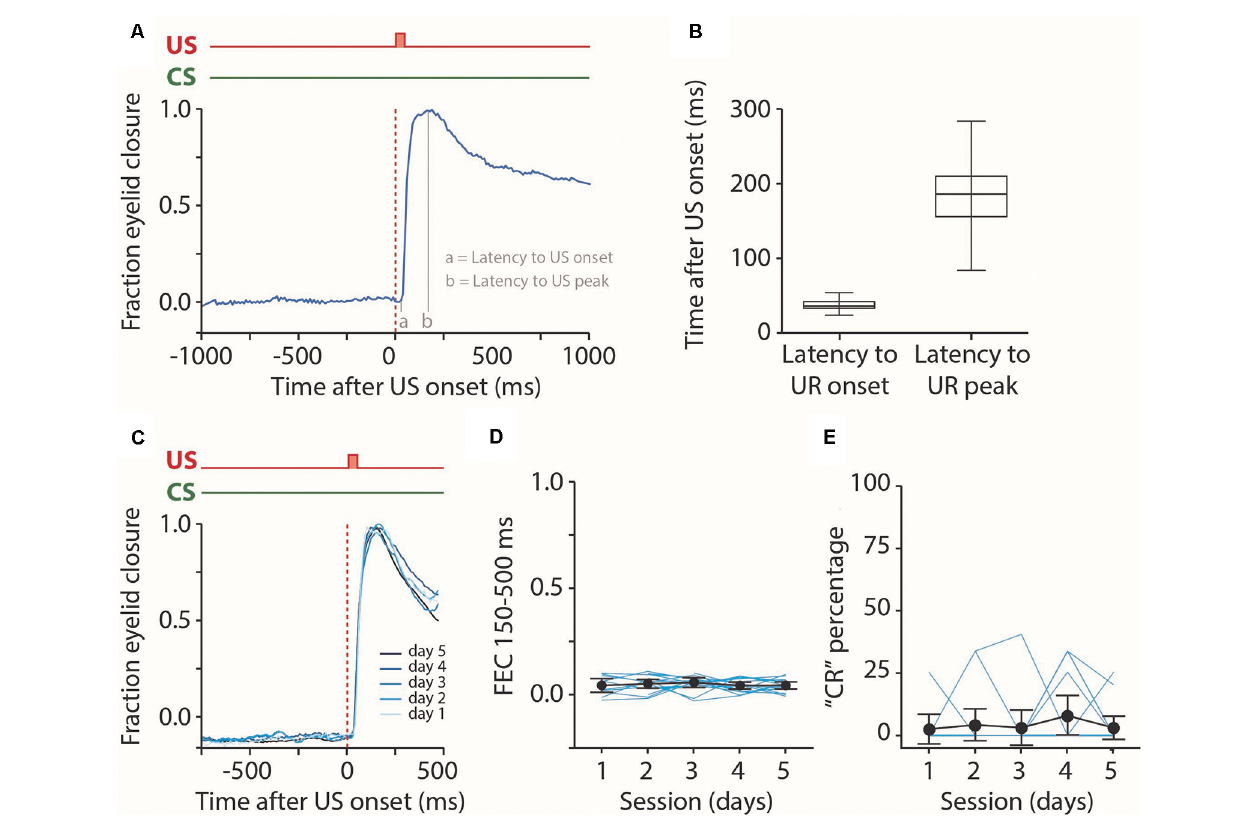
FIGURE 4 | Analysis of reflexive blinks. (A) Raw eyeblink trace showing a reflexive blink, or unconditioned response (UR), to the puff of air applied to the pig’s eye. We analyzed the latency to UR onset and latency to UR peak. (B) Median latency to UR onset and latency to UR peak for all five sessions combined. No effect was found for the session (see Table 2 ). (C) Averaged eyeblink traces for each training session. A fraction eyelid closure (FEC) of 0 corresponds with full eye-opening, while an FEC of 1 corresponds with a full eyelid closure. (D,E) Individual pig learning curves (thin light blue lines) and group-averaged learning curve (thick black line) showing the FEC 150–500 (D) and CR probability (E) as a function training session in US only trials. We used these values as a proxy for spontaneous blinks that could occur in the CS-US interval. No statistically significant effect of the session was found for FEC 150–500 nor CR probability. Error bars indicate the 95% confidence interval